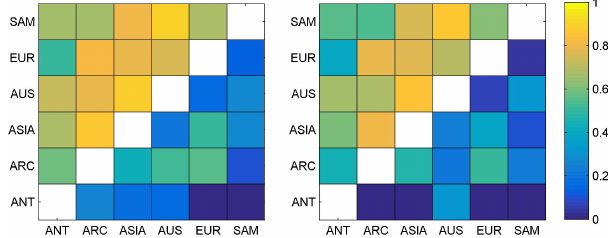
Figure 5. Correlations among the PAGES 2k regions for detrended simulated and reconstructed time series filtered using a 23-year Hamming filter. Left-hand panel: forced simulation with MPI-ESM (upper triangle) PAGES 2k reconstructions (lower triangle) for 1012–1978 CE. Right-hand panel: forced simulation with MPI- ESM for the pre-industrial period 1012–1850 CE (upper triangle) and unforced control simulation with MPI-ESM (lower